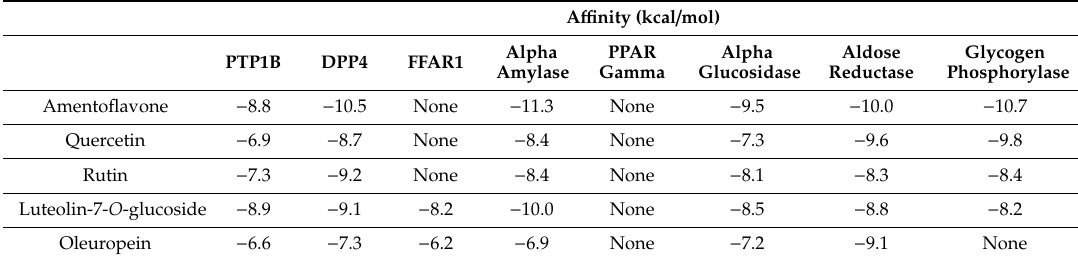
Table 3. Summary of affinities of different ligands with the receptors.